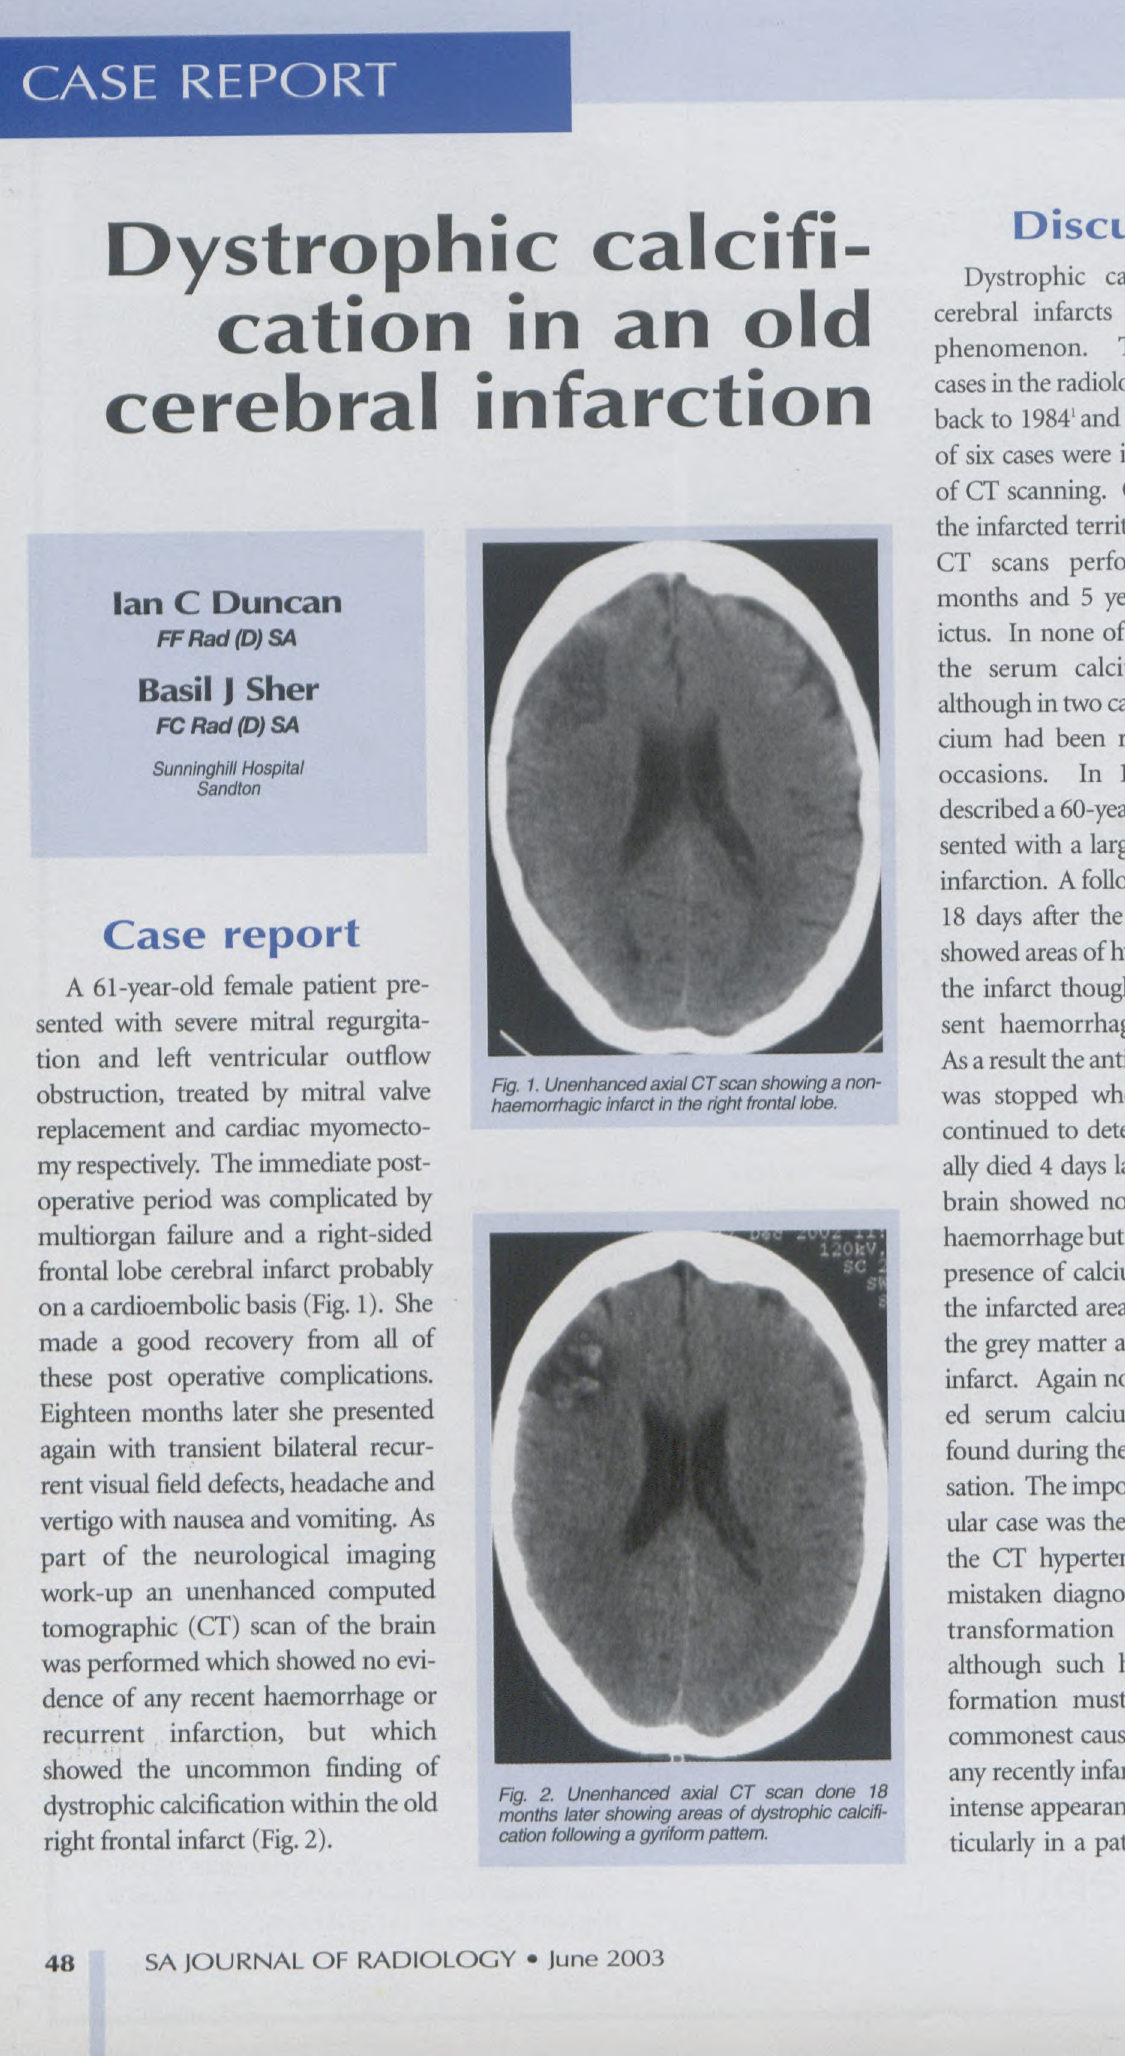
Fig. 1. Unenhanced axial CT scan showing a non- haemormagic infarct in the right fronta//obe.